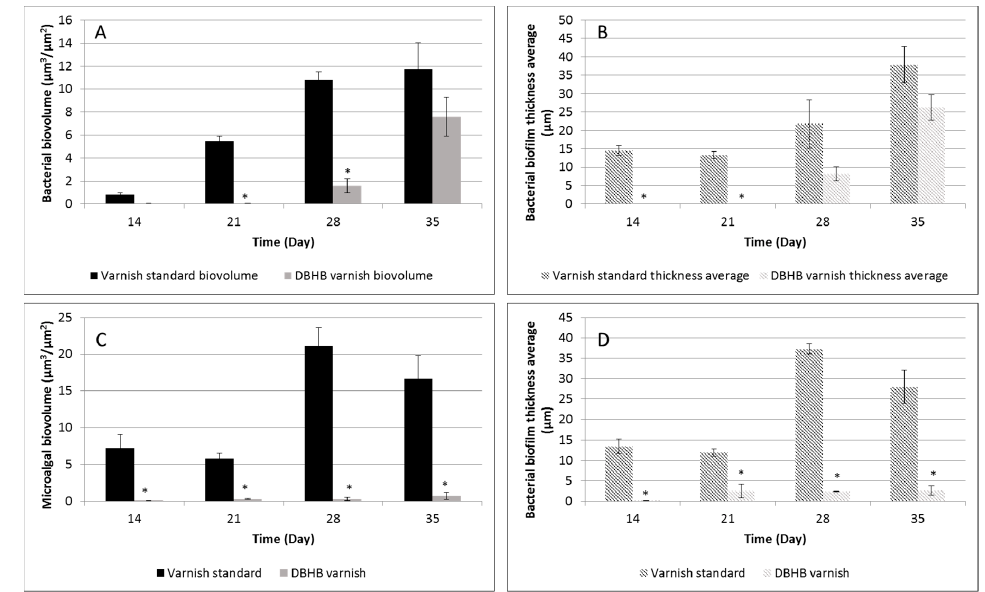
Figure 11. Biofilm quantification on coatings during in vivo immersion. Bacterial and microalgal biovolumes ( A , C ) and biofilm thicknesses ( B , D ) were determining during 35 days after COMSTAT analysis of CLSM observations. Data represent the mean ± standard deviation of replicates; * statistically significant difference at the 95% confidence level between standard (varnish without DBHB) and varnish containing DBHB.